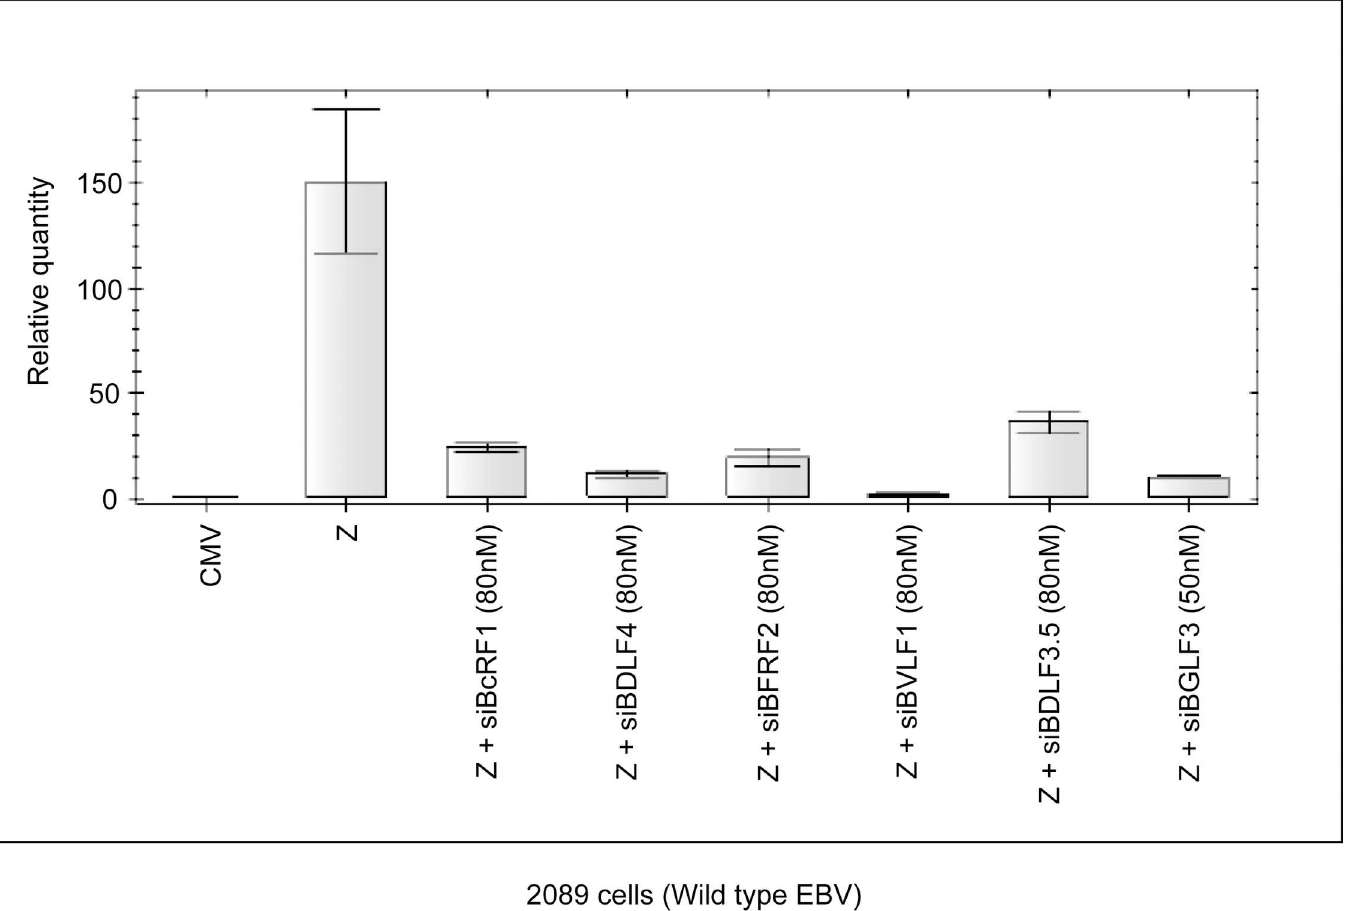
Fig 5. Silencing expression of individual late gene regulators reduced virion production. The level of extracellular DNA enclosedin virus particleswas assessed by quantitative PCR. Cell culture media from samples used to generateFig 4 were digestedwith DNase-1 to remove free extracellular DNA. Virion DNA was releasedby proteinase-Kdigestionand quantitated using primers towards EBV oriLyt. The relativeamount of encapsidated DNA was calculated using the standardcurve method. Z,